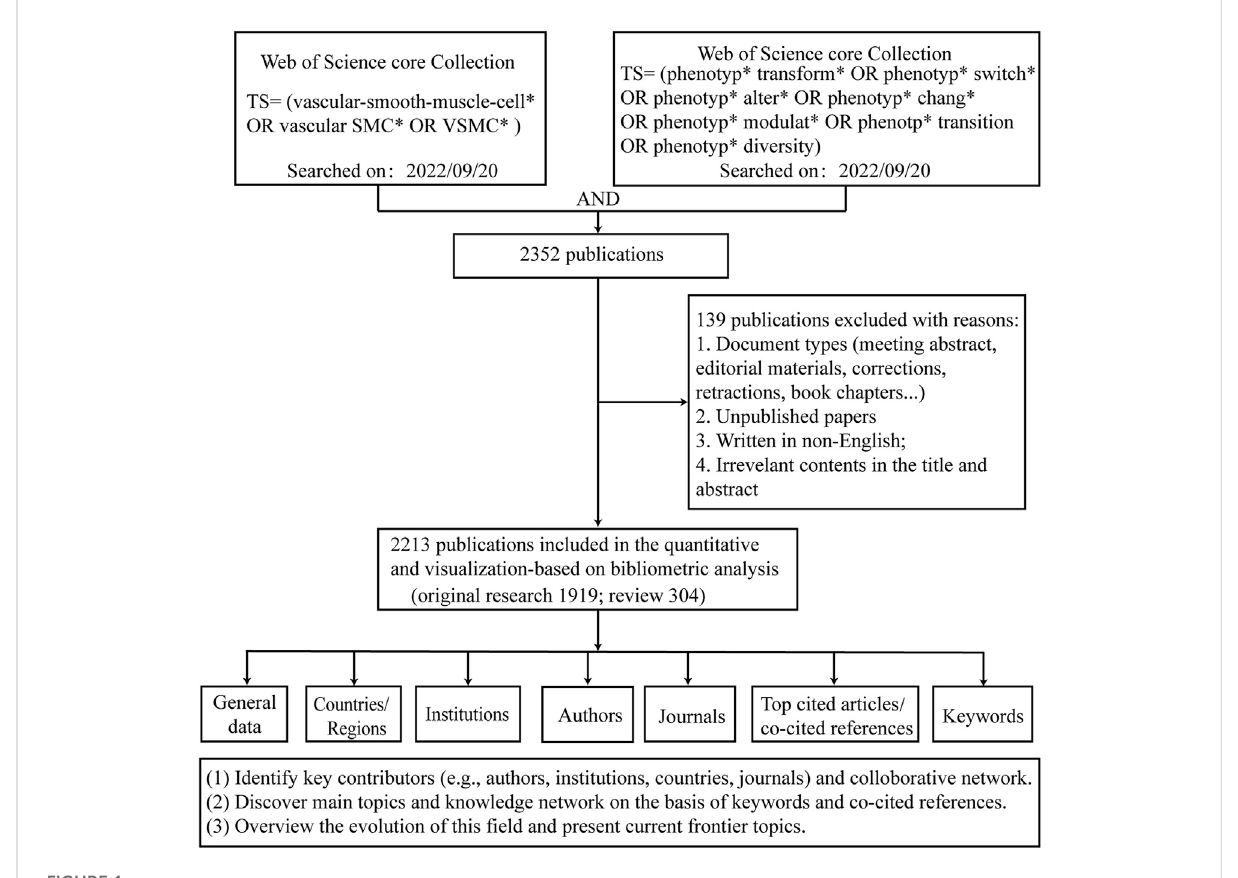
FIGURE 1 The work fl ow of data collection and bibliometric